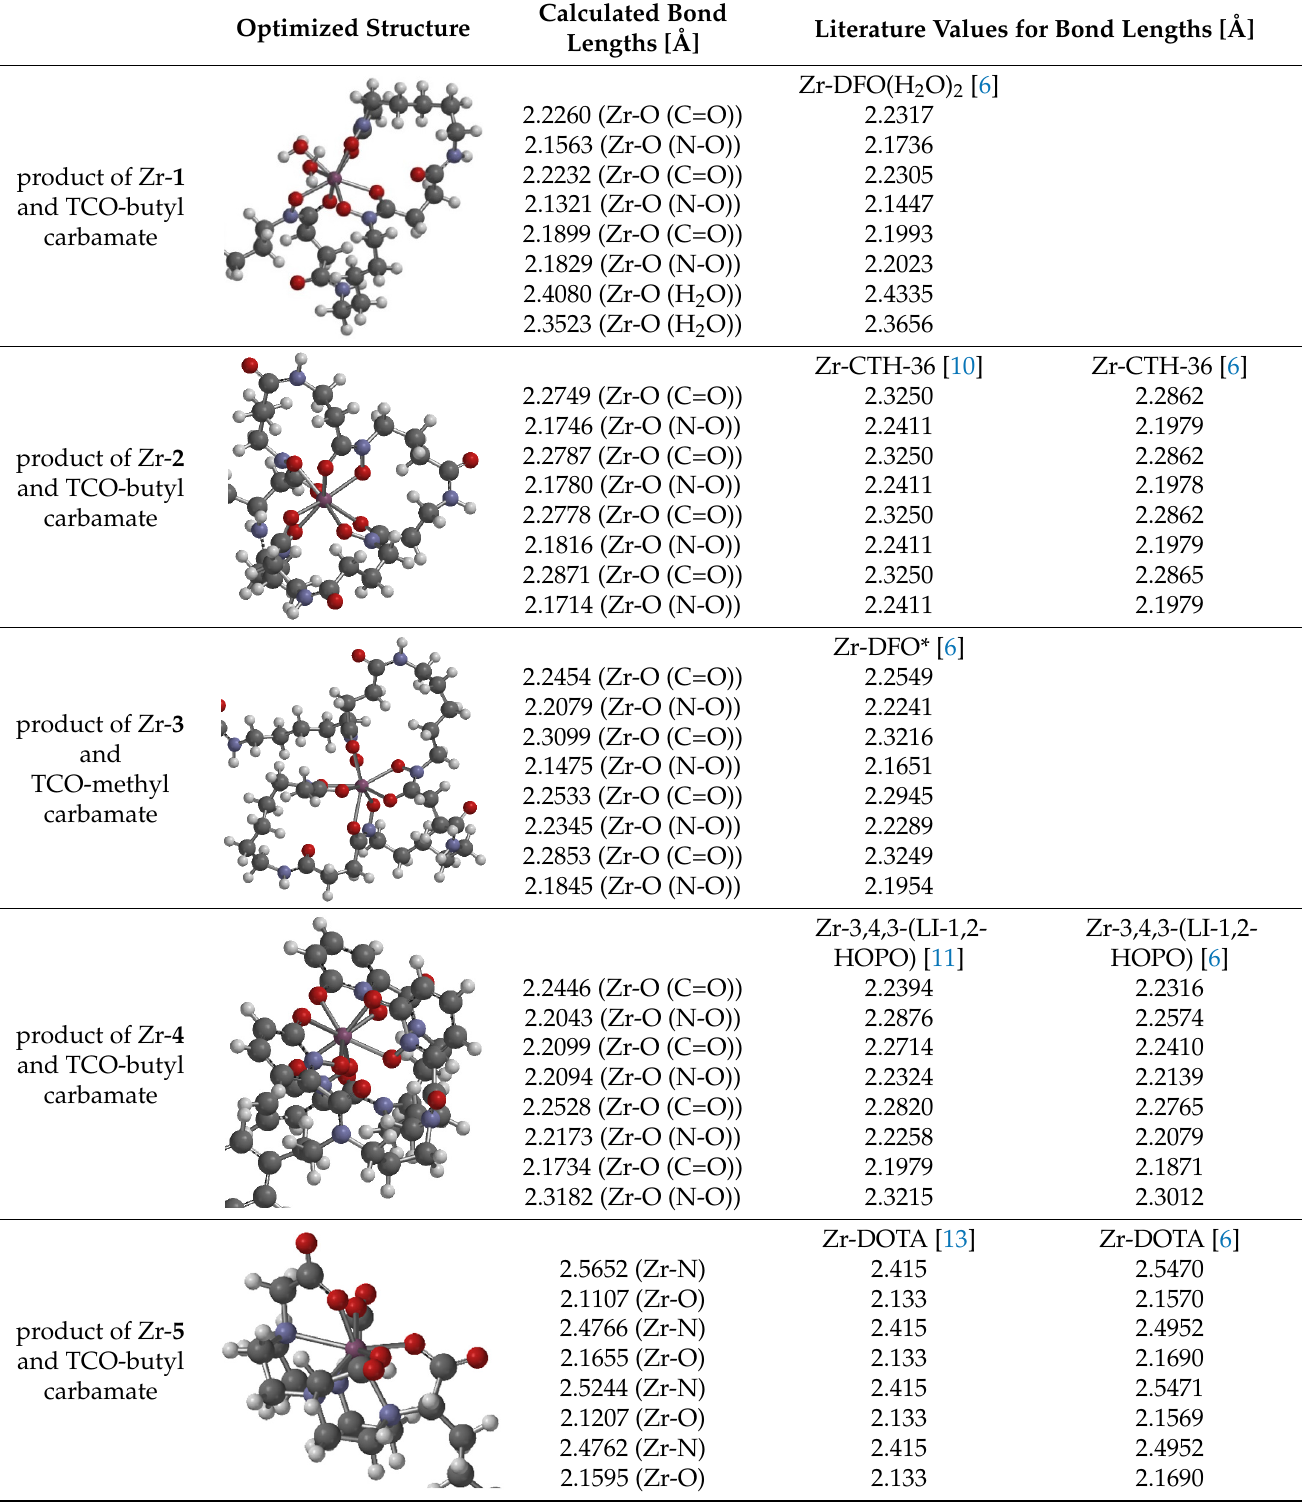
Table 1. Enlargement of the DFT-optimized geometry of the Zr complexes of 1 – 5 ; relevant bond lengths of Zr- 1 –Zr- 5 and